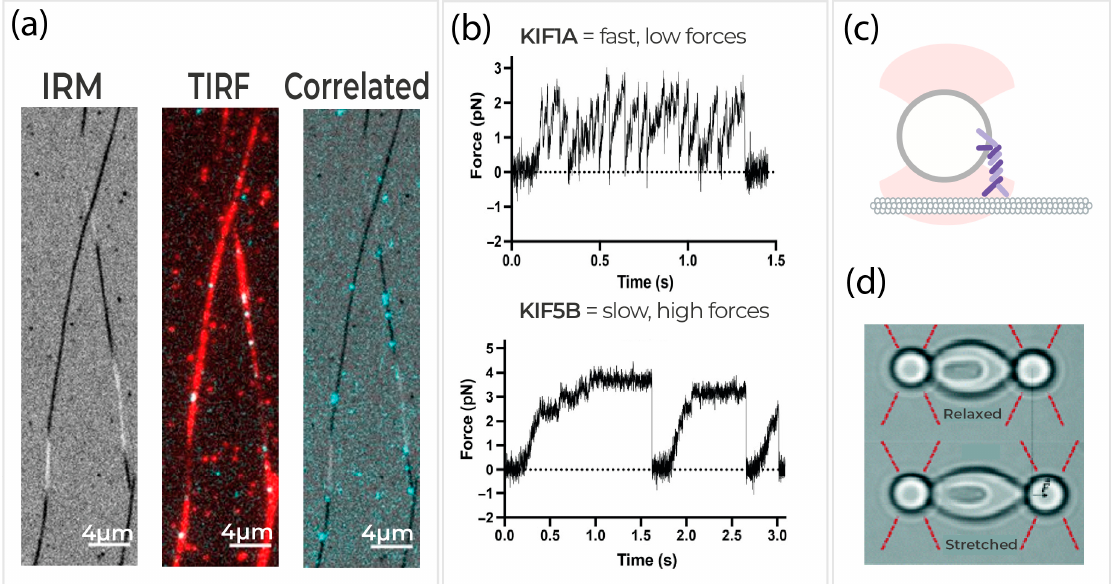
Figure 6. Characterizing the biophysical properties of motor proteins. ( a ) Example images of IRM: unlabeled microtubules visualized with IRM (note: microtubules near the surface are dark while non-adherent regions are lighter), TIRF: overlayed microtubules (red, labeled with Hilyte647) with GFP-labeled kinesins (cyan), and Correlated: overlay of IRM images with GFP-labeled kinesins. ( b ) Representative force versus time records of bead movement driven by single molecules of WT KIF1A and WT KIF5B. ( c ) Illustration of a standard surface assay for studying cytoskeletal motor proteins, such as kinesins, with optical tweezers. ( d ) Shows a red blood cell confined between two optically trapped beads in a relaxed and stretched state. In this study, the effects of strain rate and atorvastatin on RBC’s mechanical properties were measured by optical tweezers. Figures are adapted with permission from reference [77] Copyright (2021) Rockefeller University Press and reference [78] Copyright (2022) Royal Society of Chemistry.